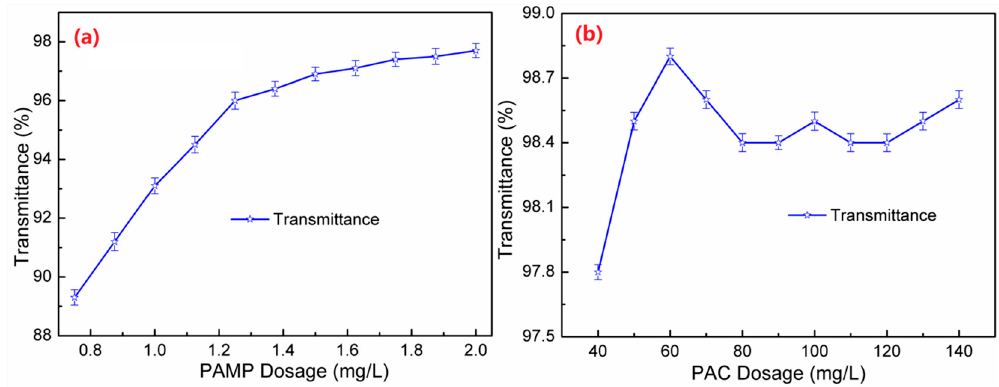
Figure 7. Effect of ( a ) PAMD dosage and ( b ) PAC dosage on transmittance. PAMD: polyacrylamide.